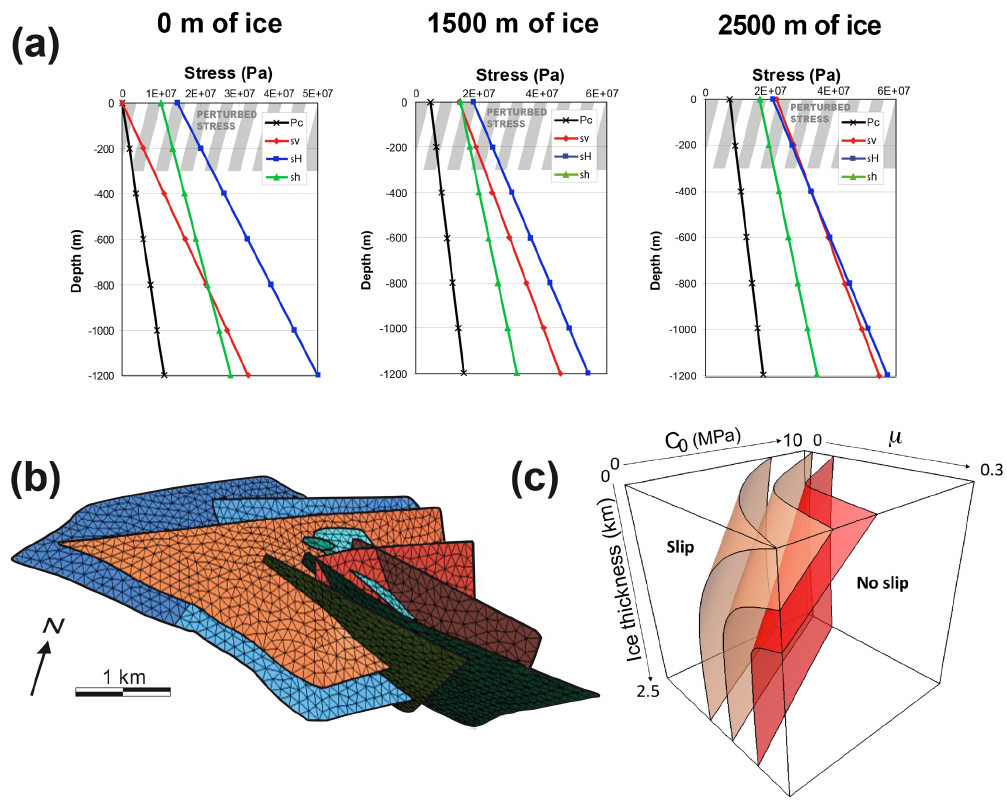
Figure 6. Case study of the Olkiluoto fault system. (a) Stress state in the rock mass applied to the fault system, measured at the present day (0m of ice) and calculated for future conditions as a function of the thickness of ice sheet cover (for 1500 and 2500m of ice). The maximum horizontal stress ( σ H ) is oriented E–W. (b) 3-D geometry of the fault system at the nuclear waste site. (c) Fault slip envelope of the Olkiluoto fault system (red surface) calculated using variable friction, cohesion, and stress profiles derived from 0 to 2500m of ice sheet cover (a) . The two pink surfaces are envelopes of values of equal maximum quasi-static displacement computed along faults, each one corresponding to a specific value of displacement (0.02 and 0.06m). See the main text for further